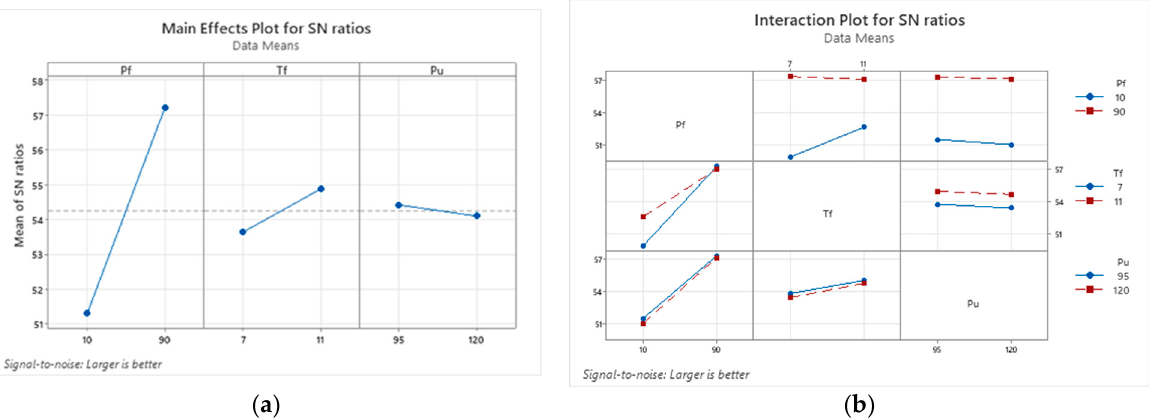
Figure 11. Medium-carbon steel–304 SS main effect ( a ) and interaction ( b ) plots for signal-to-noise ratio.